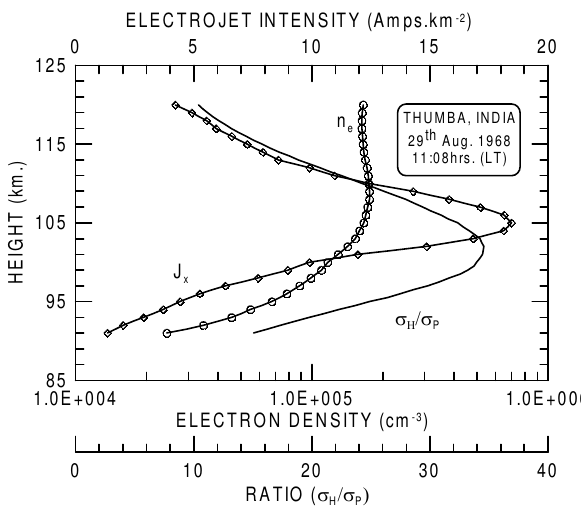
Fig. 2. Height profiles of the electron density and electrojet current intensity estimated from in-situ measurements made from Thumba, India at 11:08 LT on 29 August 1968 (Flight 20.06), compared with the model estimate of the ratio of Hall to Pedersen conductivity pro- file.